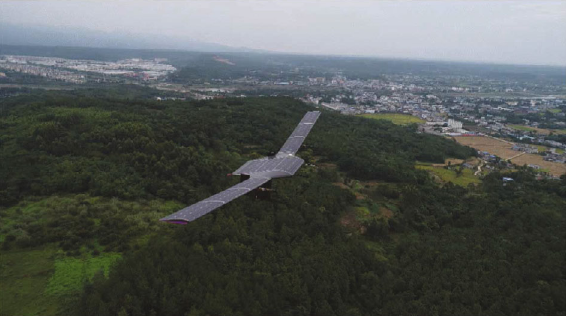
Figure 22: Flight test of prototype.